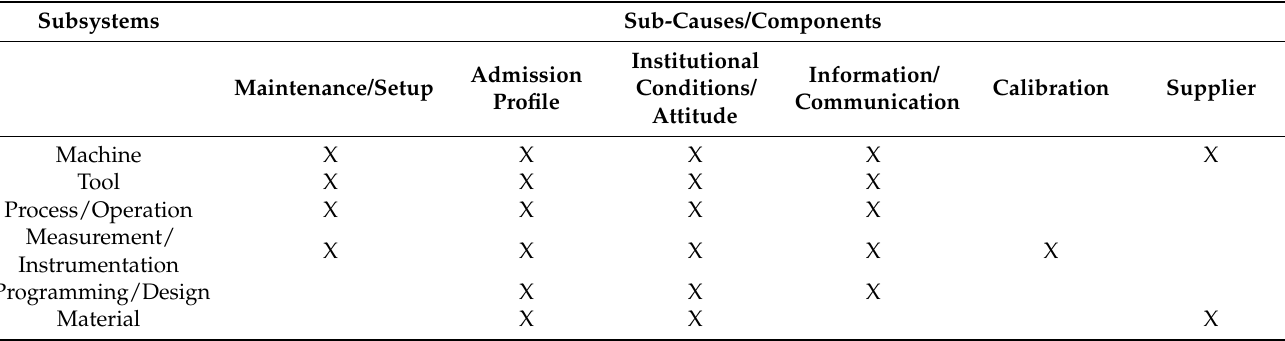
Table 3. Matrix of the component–subsystem